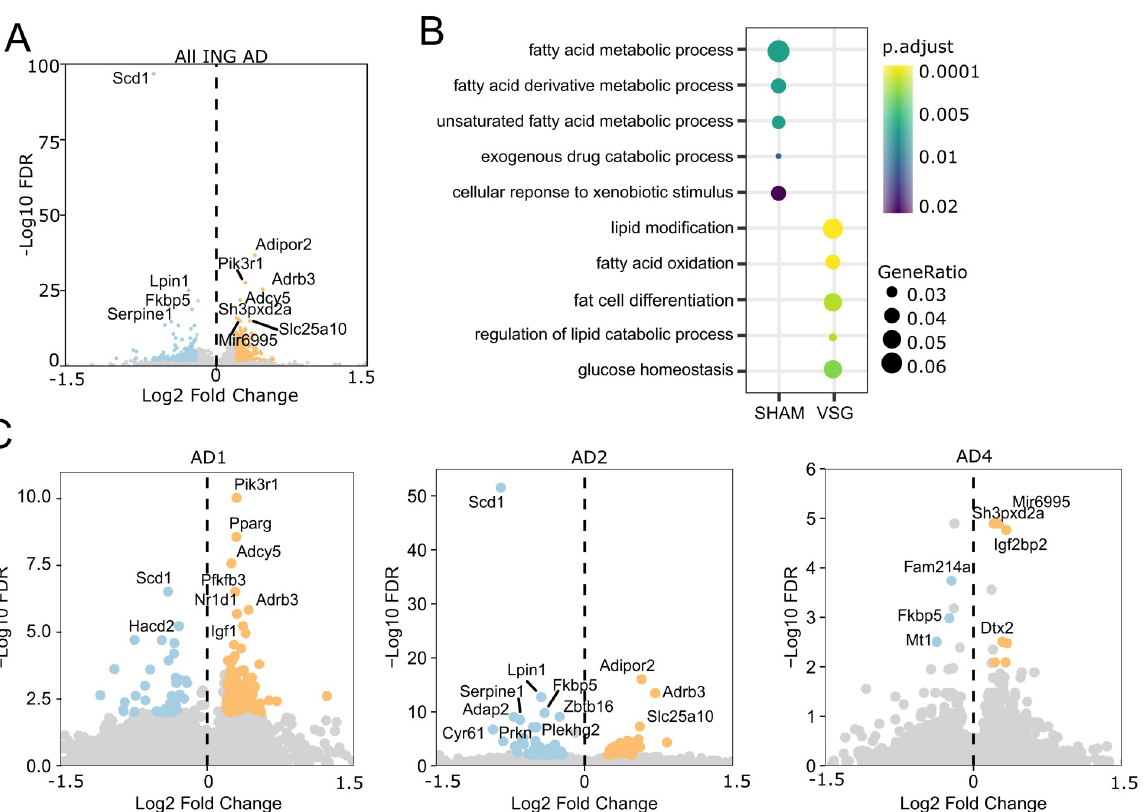
Fig 4. Accessibility changes in genes after VSG in inguinal mature adipocytes. A. Volcano plot of differentially accessible genes comparing VSG to SHAM ING adipocytes. Positive fold change indicates increased accessibility in VSG cells. B. Biological process gene ontology enrichment for the top 200 most significantly differentially accessible genes. C. Volcano plots of differentially accessible genes in VSG vs SHAM in each mature adipocyte cluster.